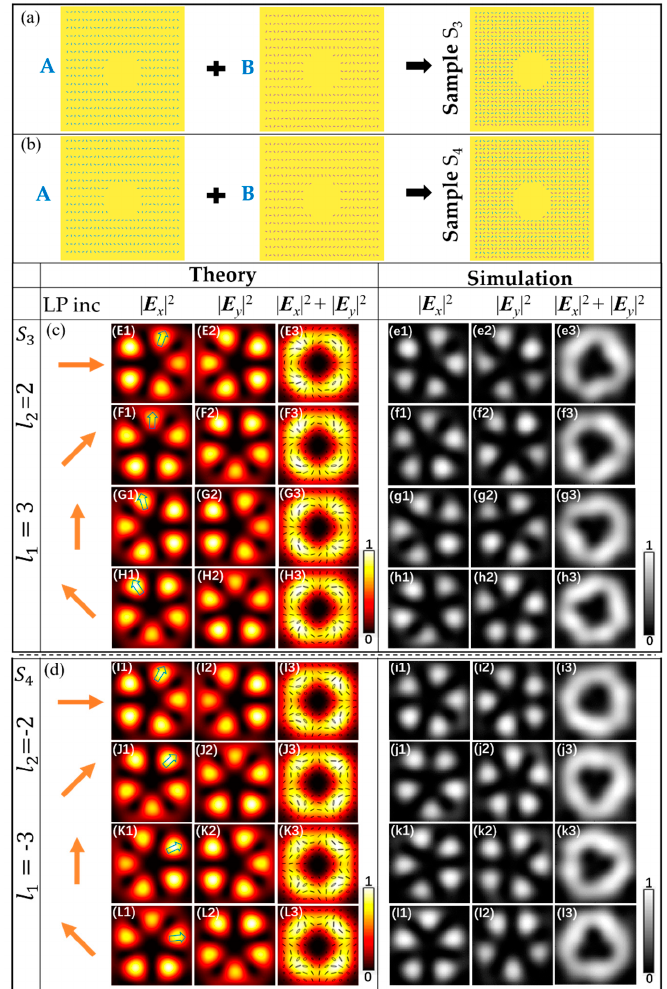
Figure 3. Theoretical and simulated intensity profiles of the vector beam for the samples S 3 and S 4 under LP illuminations. ( a ) schematic of the structure of sample S 3 . ( b ) schematic of the structure of sample S 4 . The two samples S 3 and S 4 with parameter ( l A , l B ) = (3, 2) and ( − 3, − 2) are shown in the first column of ( c ) and ( d ), respectively. ( c ) and ( d ) patterns from the top to bottom rows are different polarized cinquefoil vector beam and cinquefoil π -vector beam under LP light with different polarization directions, respectively. The schematics of the incident light and the intensity pattern of | E x | 2 , | E y | 2 , and | E x | 2 + | E y | 2 are shown from left to right.